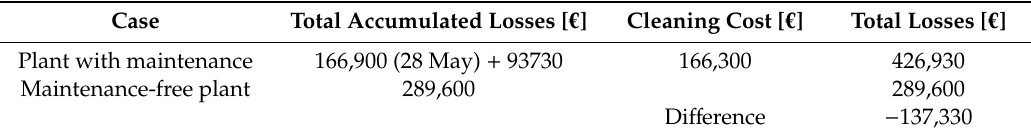
Table 10. Economic losses incurred in the 50 MWp plant for the two proposed scenarios.